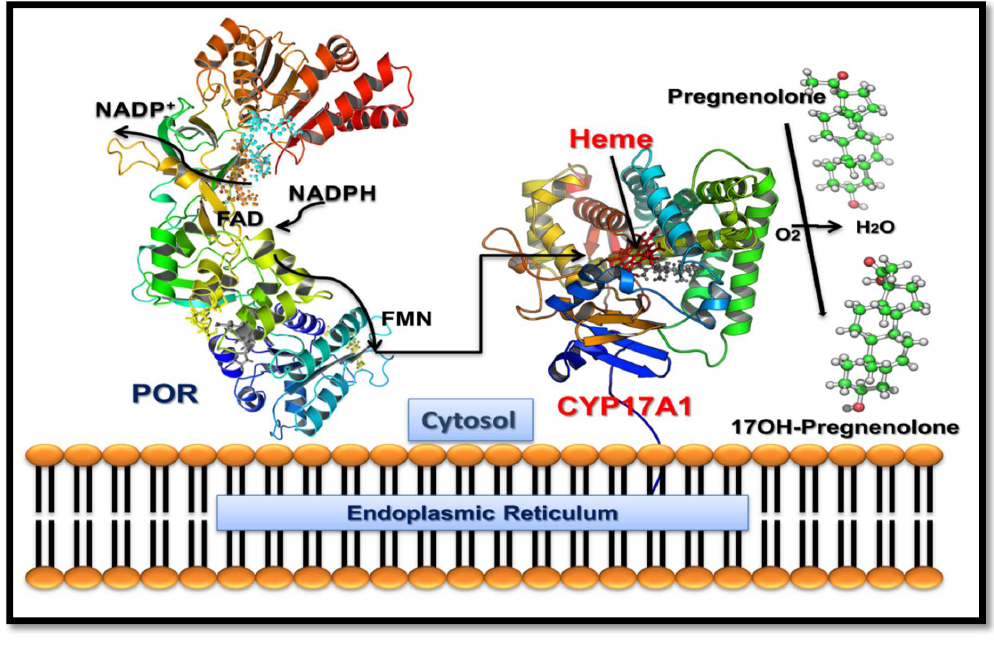
Figure 1. Schematic diagram of CYP17A1 and P450 oxidoreductase (POR) interaction in the membranes. The nicotinamide adenine dinucleotide phosphate (NADPH) molecules bind to POR, which is embedded into the membranes of endoplasmic reticulum and donate a pair of electrons, one at a time, which are received by the FAD. Transfer of electrons to FAD creates a change in conformation of POR, allowing the FAD and FMN groups to move towards each other, which facilitates the transfer of electrons from FAD to FMN. The FMN domain of POR interacts with the CYP17A1 and transfers electrons for catalytic